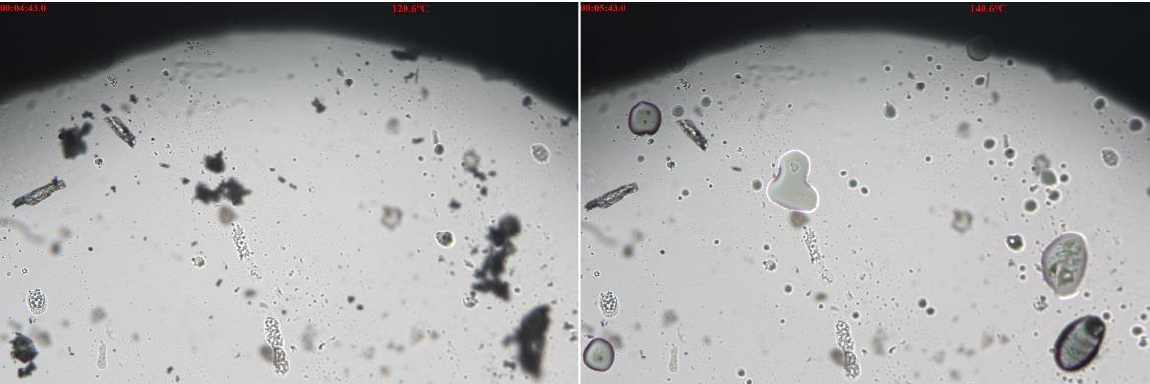
Figure 6. Polarized optical microscopy of anhydrous 1,5-pentanediamine adipate ( left : 120.6 °C, right : 140.6 °C).